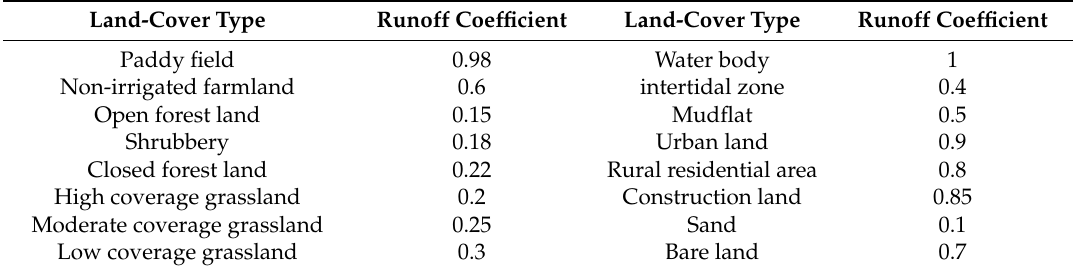
Table 2. Land-cover type and the corresponding runoff coefficient